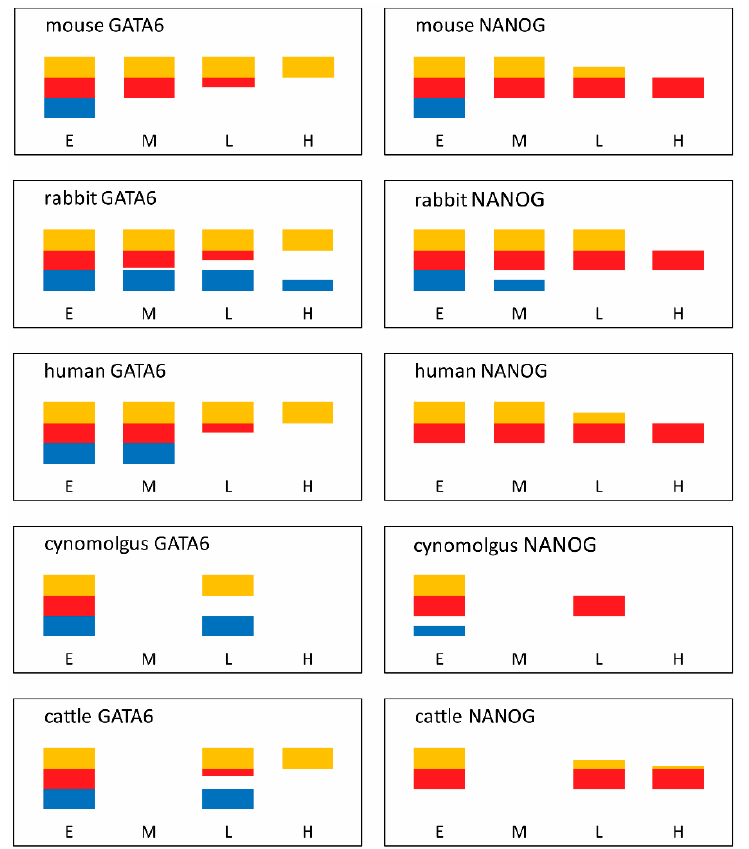
Figure 4. NANOG and GATA6 protein distribution in early (E), mid (M), late (L) and hatched blastocysts of various mammals. Lineages are colour coded: blue being trophoblast, red epiblast and yellow hypoblast. Blastocyst stages E, early, M, mid, L, late and H, hatched defined as per Table 2. Note extended expression of GATA6 in rabbit, old world monkey and cattle trophoblast at late blastocyst stages and extended maintenance of NANOG in rabbit prospective hypoblast at the late blastocyst stage.